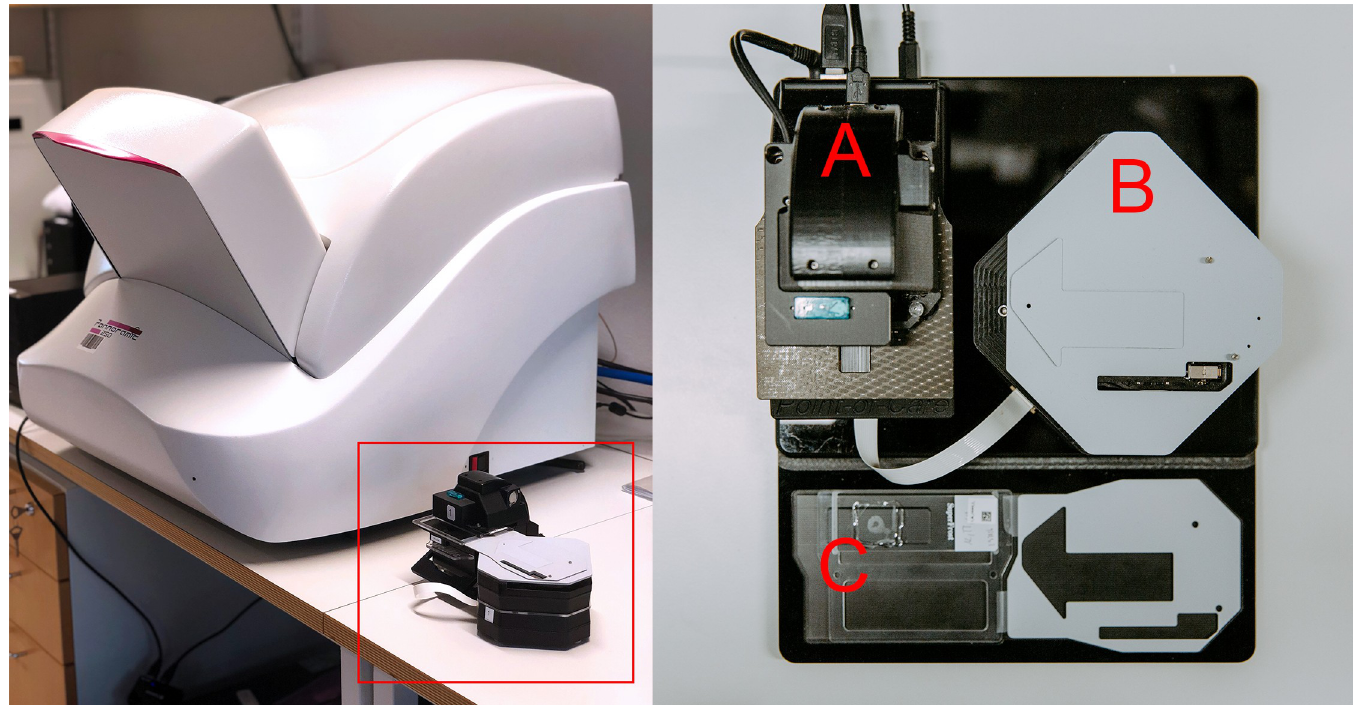
Fig 1. Miniature microscope scanner prototype. Left: Miniature microscope scanner “MoMic” (red bounding box) next to reference whole slide scanner. Right: Overview of the device showing main microscope unit housing camera module (A), motor unit for sample navigation (B) and glass slide holder (C).